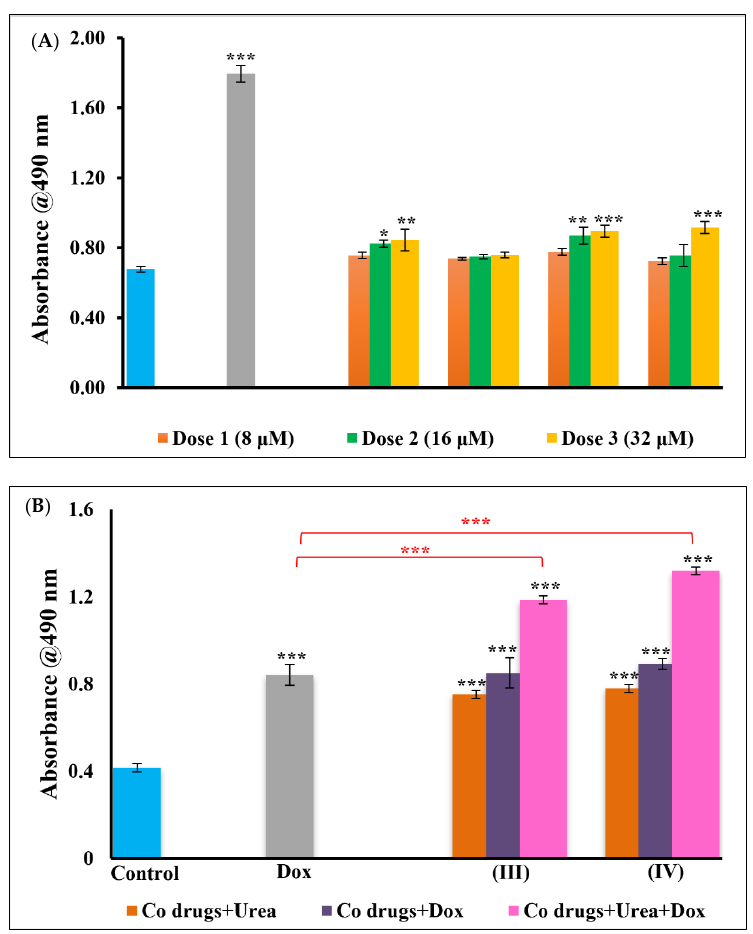
Figure 3. LDH levels of A549 cells. ( A ) The control cells (untreated) and cells treated with different concentrations (8 µ M, 16 µ M, and 32 µ M) of the cobalt (III) complexes and doxorubicin (50 nM) showed different levels of LDH release. ( B ) Significant LDH release was observed when the optimized dose of the cobalt complexes (32 µ M) was combined with urea (2 mM) and doxorubicin (50 nM) in treated groups. The action of doxorubicin was fairly increased when the complexes ( III and IV ) were combined with urea. Loss of membrane integrity and LDH release can be directly related to pH increase and facilitating Doxorubicin into cells. The data represent the mean ± SEM. Results are significantly different at * p < 0.05, ** p < 0.01 and *** p < 0.001 when compared to control and